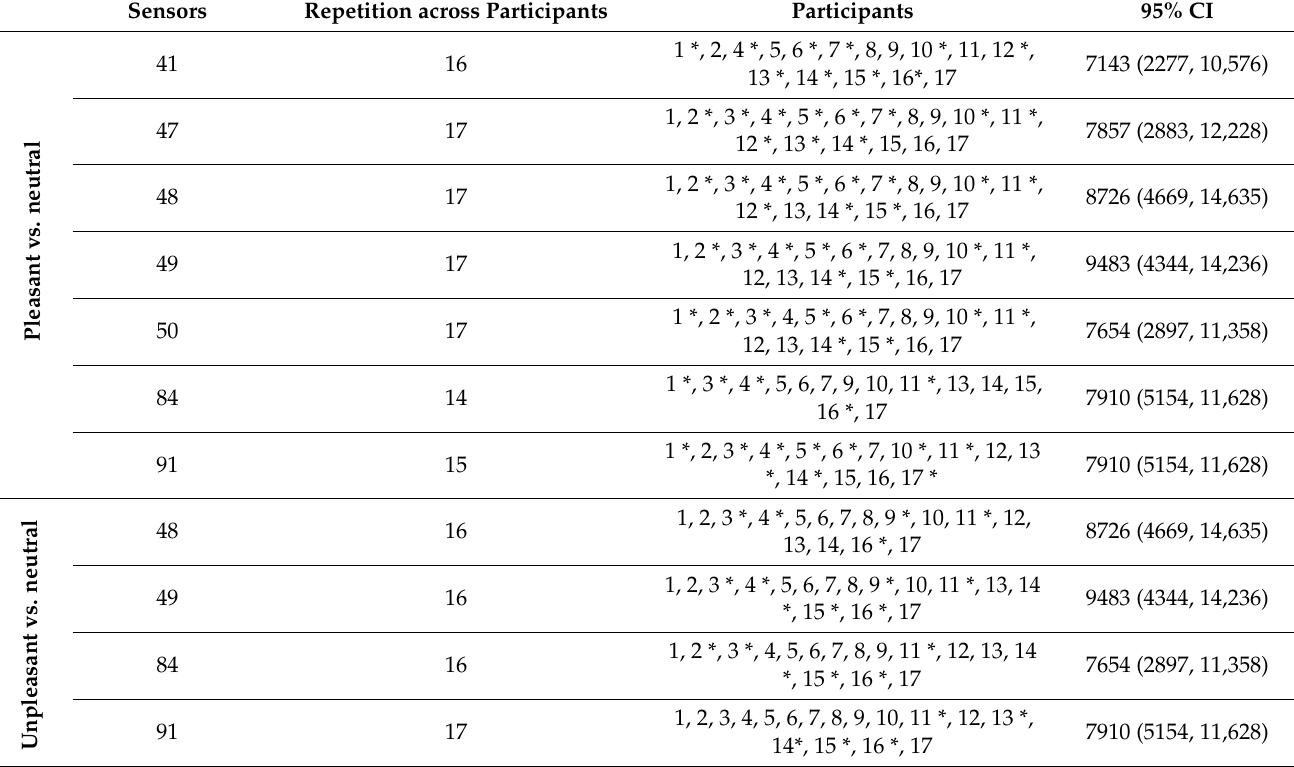
Table 1. Most frequently selected sensors comparing brain responses to high-arousing emotional versus neutral pictures across all participants. The most common sensors between participants, selected considering 95% confidence intervals of bootstrapping replications, are presented in this table. In highlighted participants with an asterisk, the brain responses to high-arousing versus neutral stimuli were significantly higher. The numerical values in the labeled 95% CI column represent the median as well as the 95% CI of the bootstrapping replications for the selected sensors (see orange sensors in Figure 4). Sensors Repetition across Participants Participants 95%